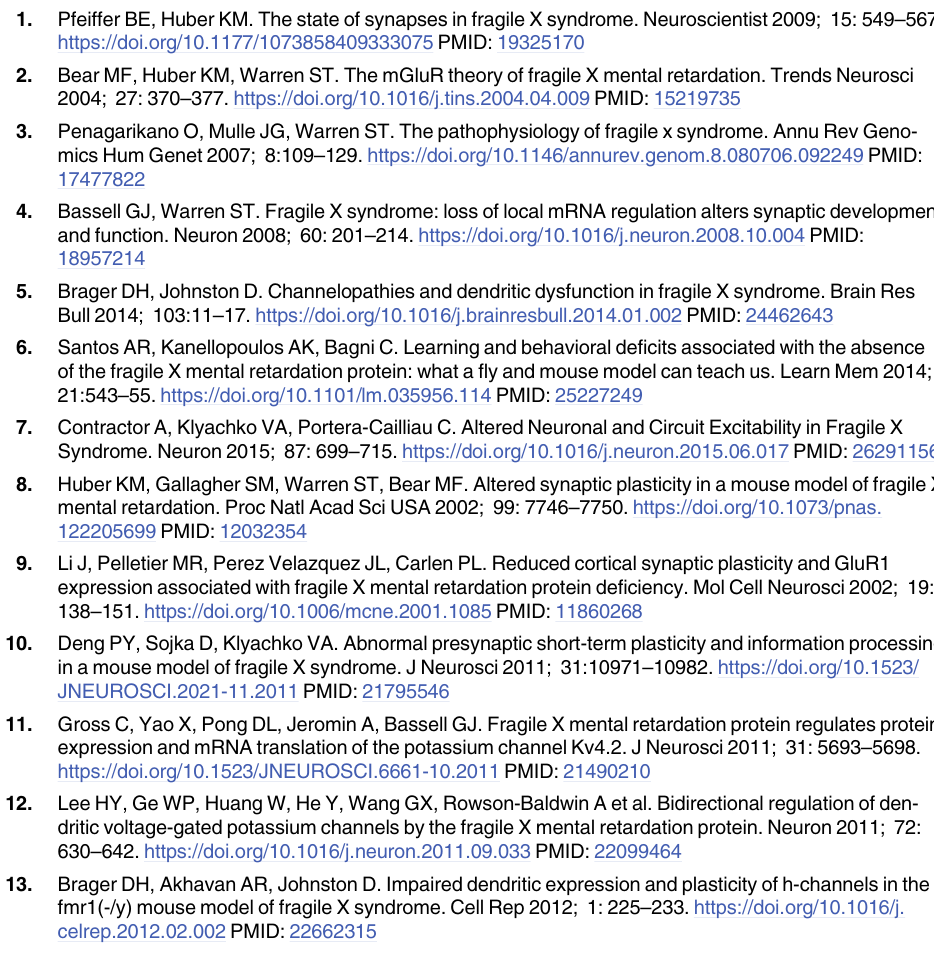
S2 Table. Membrane properties of the CA1 pyramidal cells in Fmr1 KO